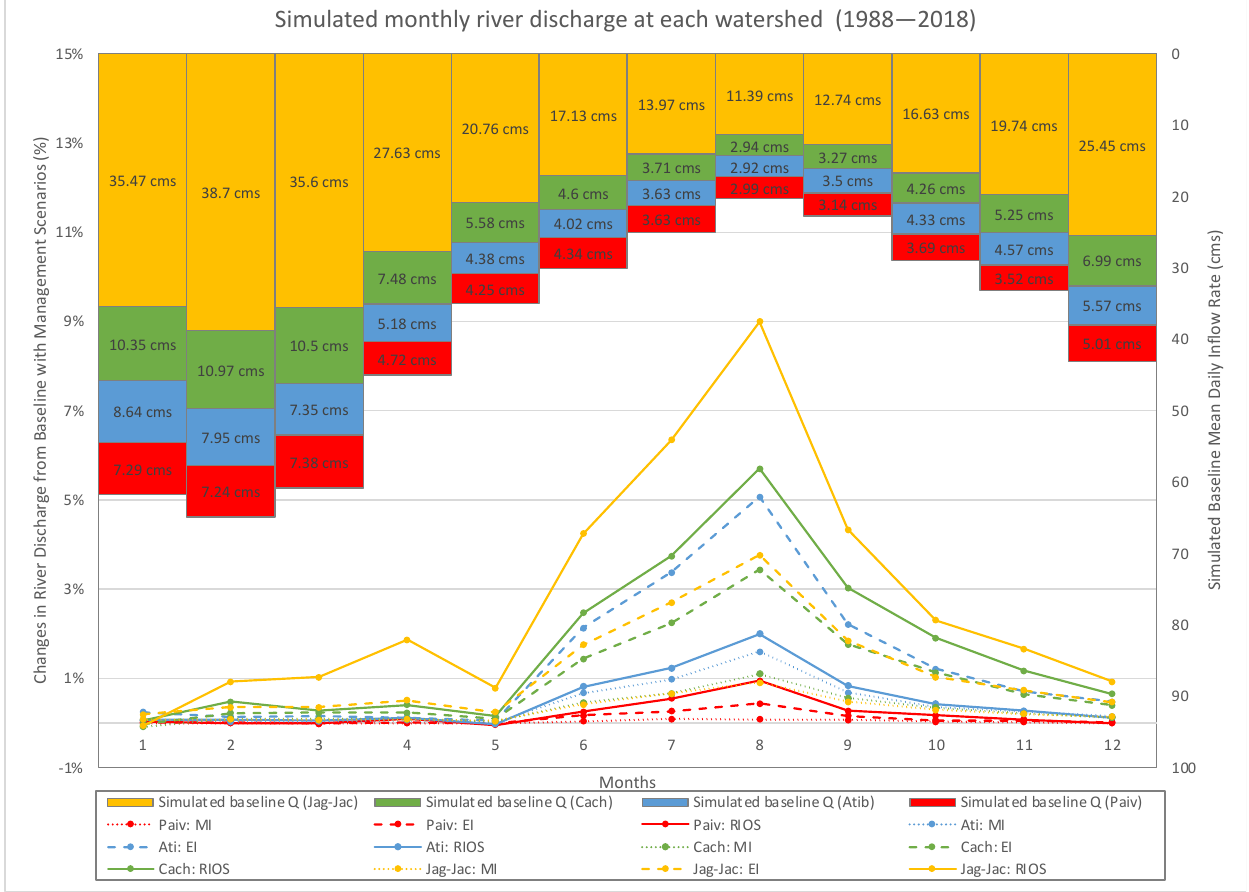
Figure 9. Average observed daily inflow rates from years 1988 to 2018 are compared with calibrated and validated HEC-HMS and SWAT model outputs. ( a )